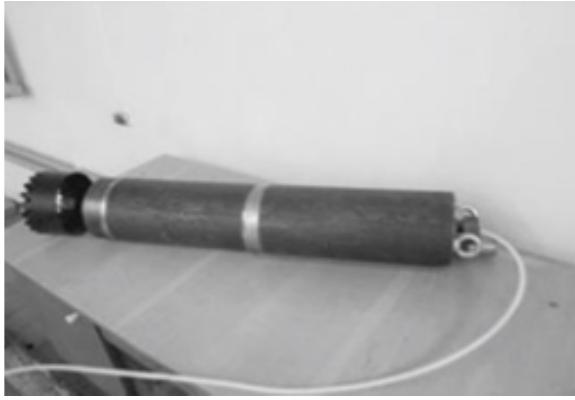
Figure 5. Small drilling unit [26].